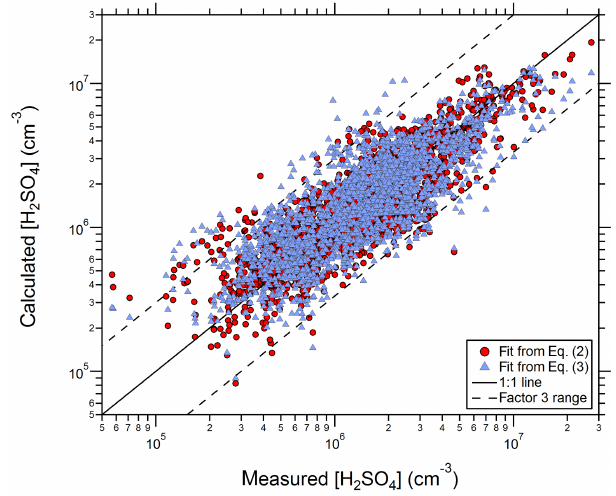
Figure 4. Calculated [H 2 SO 4 ] as a function of the measured concentrations. Only data points where the global radiation ex- ceeded 50Wm − 2 were considered in deriving the fit parameters for Eqs. (2) and (3). The red circles take into account SO 2 , global radiation (Rad), condensation sink (CS) and relative humidity (RH) to calculate the [H 2 SO 4 ], whereas only SO 2 and global radiation are used for the blue